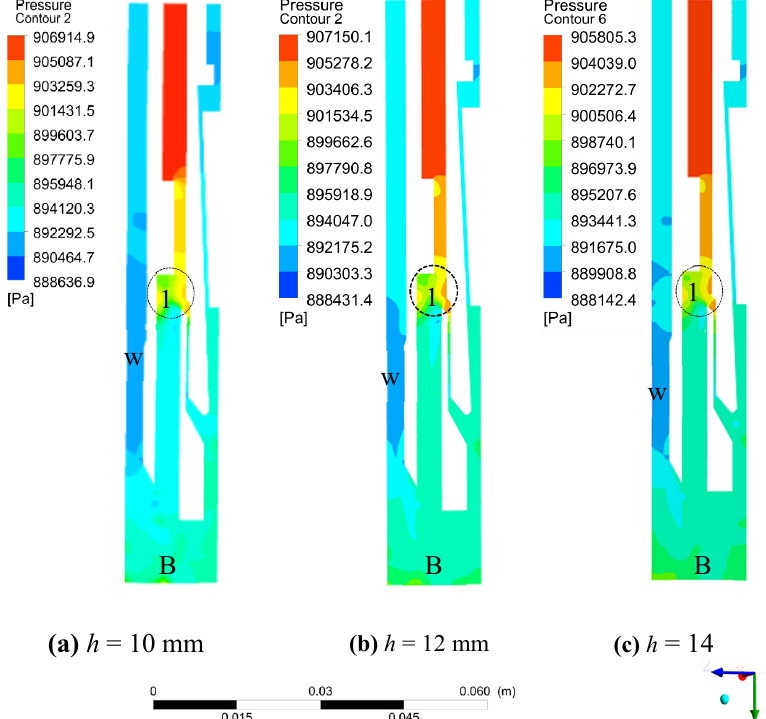
Figure 7. Pressure nephogram of main waterway section ( a ) h = 10 mm; ( b ) h = 12 mm; ( c ) h = 14 mm.